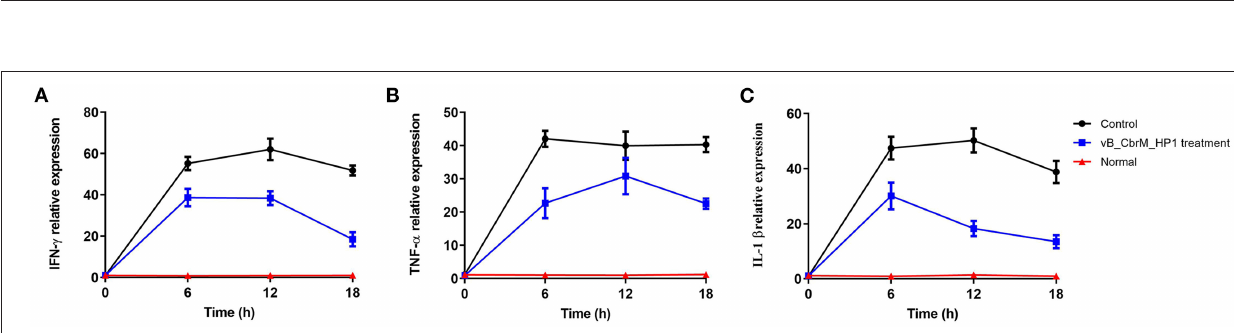
Frontiers in Veterinary Science |